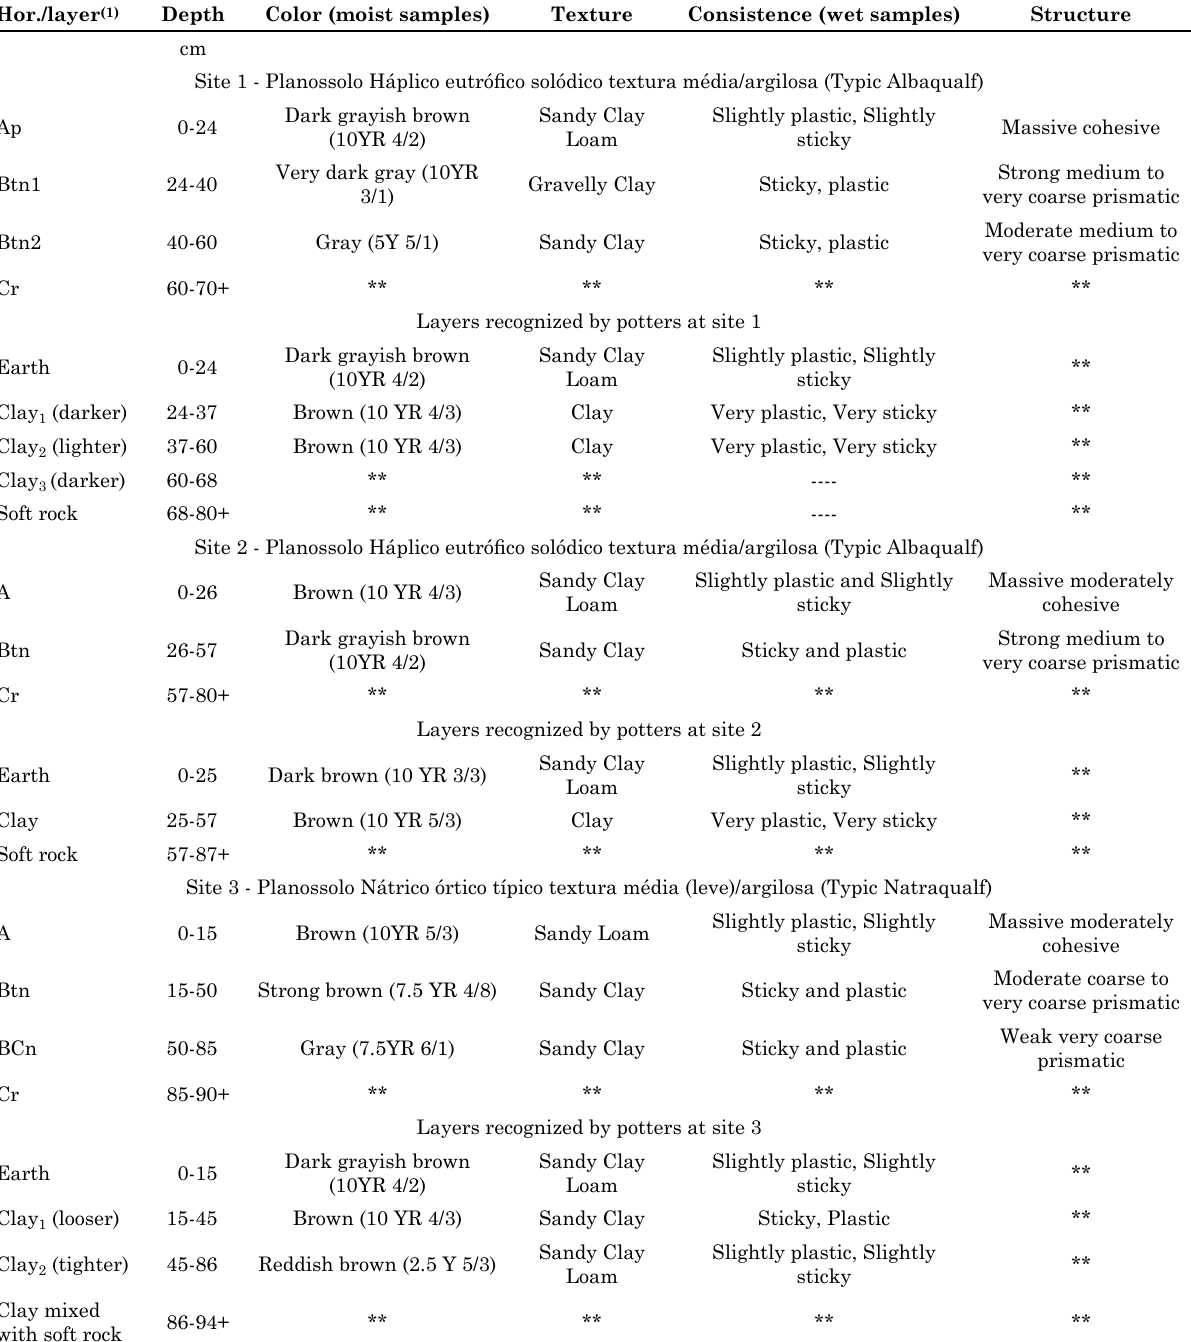
table 1. morphological properties of soils used as a source of “red clay” by peasant potters in altinho, Pernambuco,